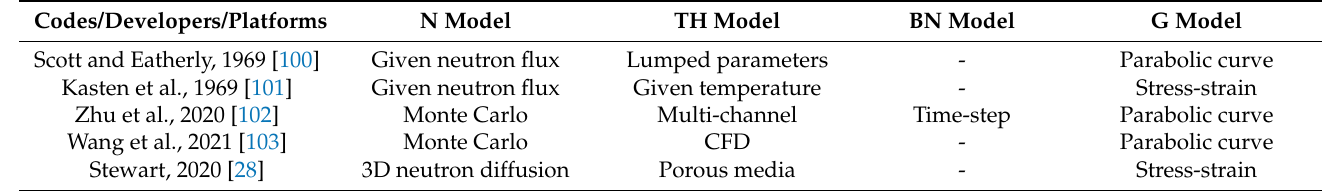
Table 3. Development status of the N-TH-BN-G coupling